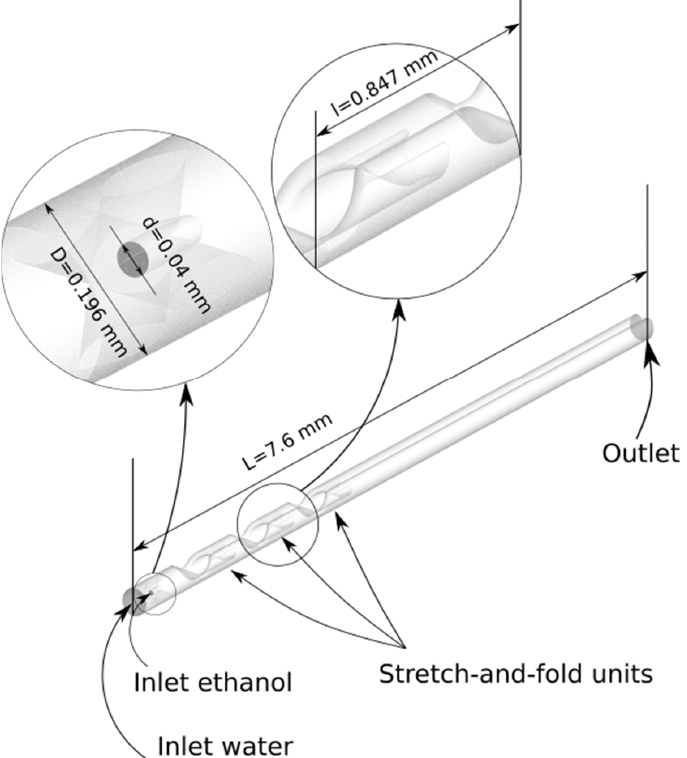
Figure 1. llustration of the 3D ‐ CLM design with three stretch ‐ and ‐ fold units as flow domain for the Figure 1. Ilustration of the 3D-CLM design with three stretch-and-fold units as flow domain for simulations. the